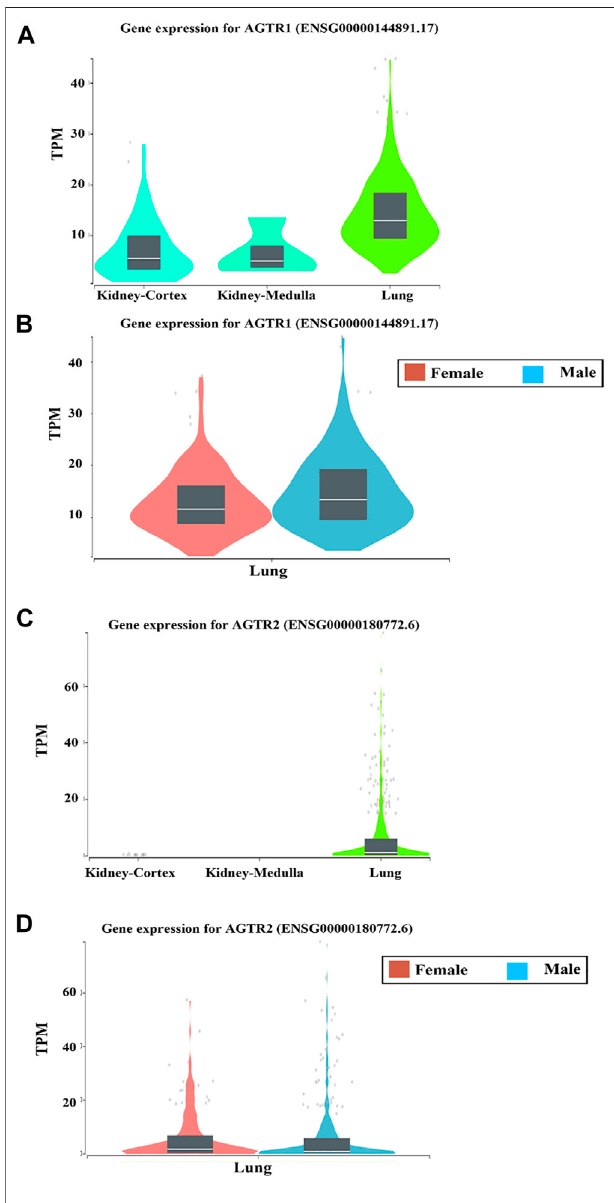
FIGURE 4 | The mRNA expression levels of AGTR1 and AGTR2 in lung and kidney tissues using The Genotype-Tissue Expression (GTEx) project (www.gtexportal.org) portal.The prostaglandin D2 receptor 2 (PTGDR2), involved in type 2 innate immune response and well known for its role in airway in fl ammation is another gender differential gene in the lung